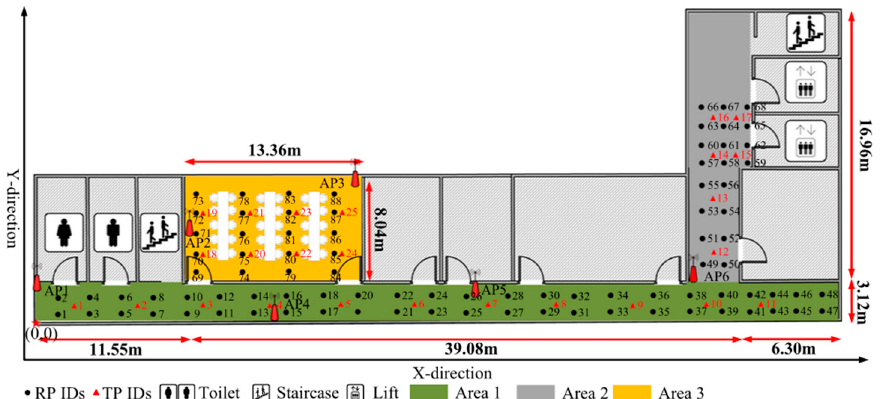
Figure 2. Test Bed. Corridor, office, lobbies environment scenarios. Table 1. DAP-Link Aps, Scenarios, Coordinates, and Mac Address Matrix.